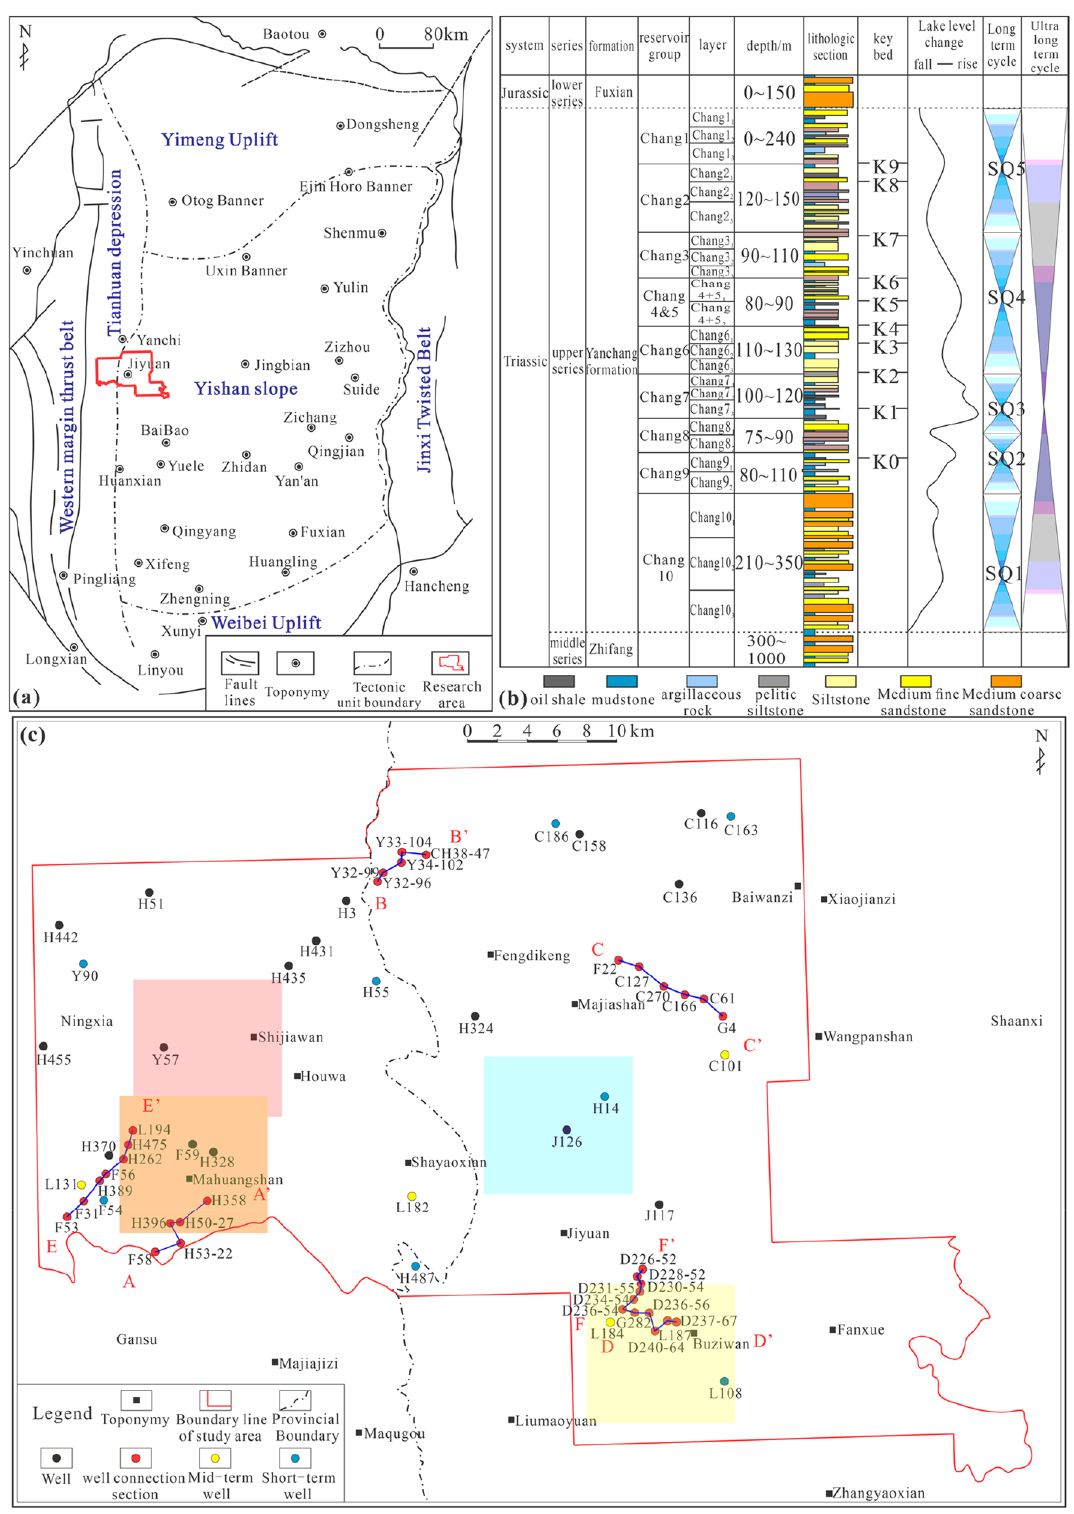
Figure 2. ( a ) Basin structural division and study area location (modified from reference 13 . Created using CorelDRAW-X9 21.2.0.706 (http:// www. corel draw. com/ cn/); ( b ) Yanchang Formation sequence stratigraphic division (modified from reference 3 . Created using CorelDRAW-X9 21.2.0.706 (http:// www. corel draw. com/ cn/) ( c ) Well location distribution in the study area (AA’ is the well connection profile of F58-H358; BB’ is the well connection profile of Y32- 99-CH38-47; CC’ is the well connection profile of F22-G4; DD’ is the well connection profile of D236-54-D237-67; EE’ is the well connection profile of F53-L194; FF’ is the well connection profile of D236-54-D226-52. The red, blue, orange and yellow shaded areas correspond to the extents of the skeleton architectural elements FA1, FA6, FA2 and FA4 in "The spatial distribution characteristics of architectural elements" Section, respectively.) Created using GeoMap v3.6 (http:// www. juras sic. com.